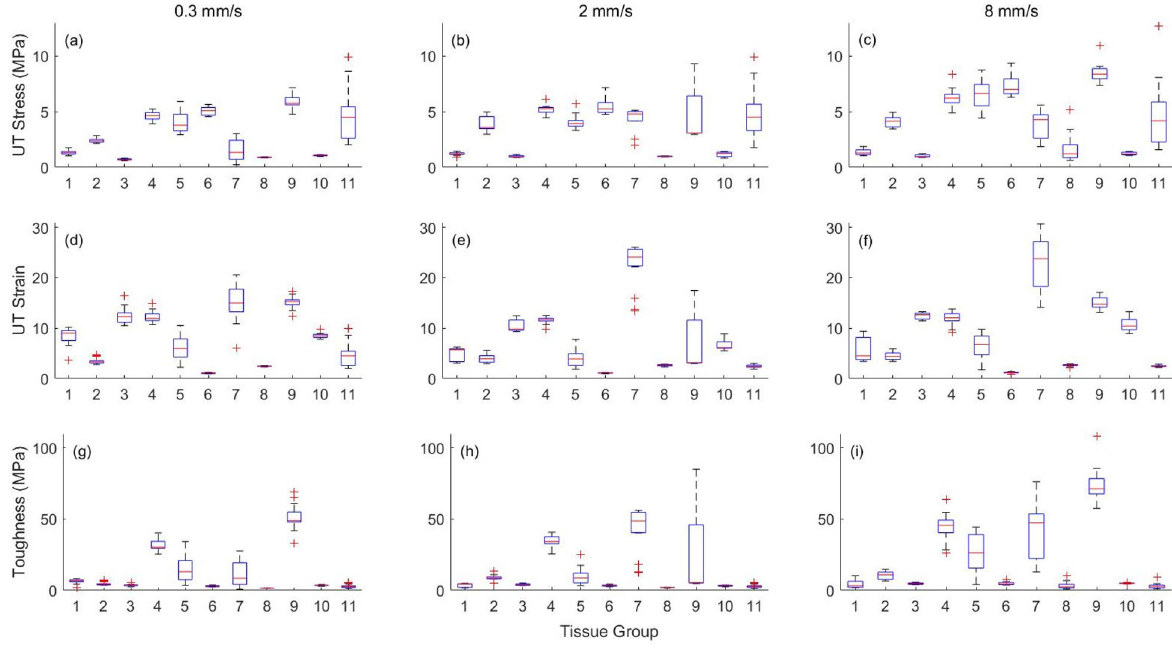
Figure 2. Boxplots of ( a )–( c ) ultimate tensile stress (UT Stress), ( d )–( f ) ultimate tensile strain (UT Strain), and ( g )–( i ) toughness of synthetic (tissue groups 1–10) and full thickness burned porcine skin (tissue group 11) tissue samples loaded at 0.3 mm/s, 2 mm/s, and 8 mm/s.